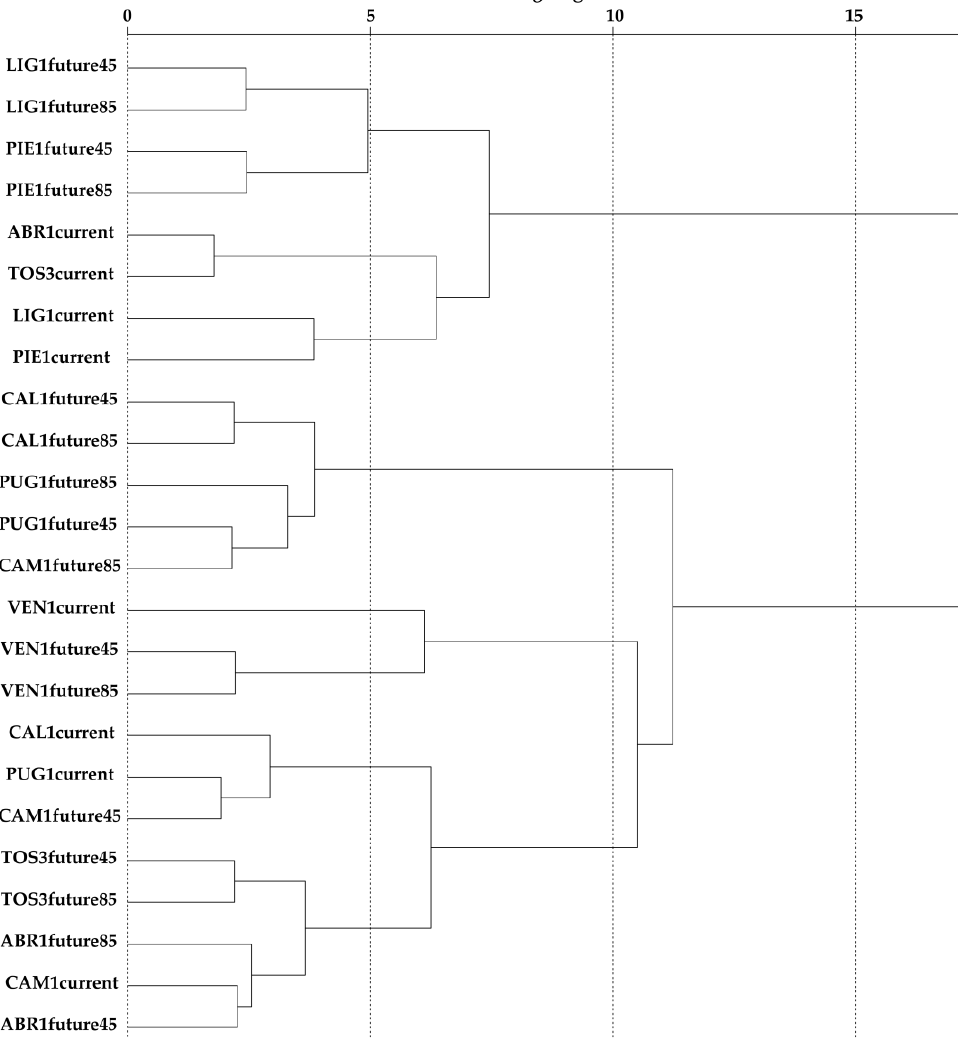
Figure 4. Hierarchical clustering for the experimental sites using Euclidean distance matrix decomposed with Ward's agglomeration rule, for different climate scenarios.